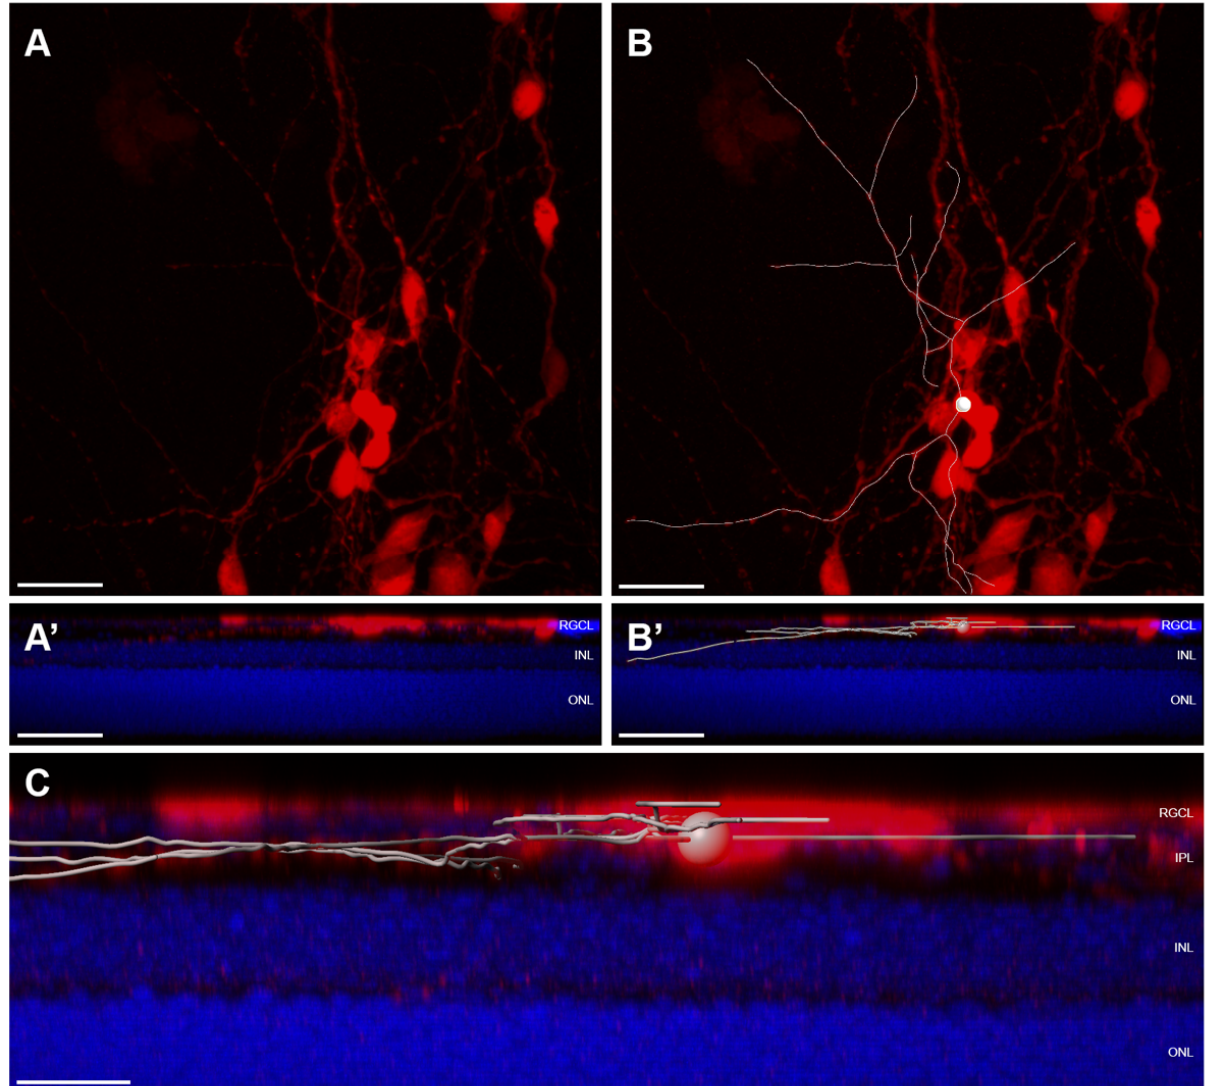
Figure 5. Three-dimensional reconstruction of confocal microscopy showing in vivo transplanted hESC-RGCs (red) in pronase-treated wildtype mouse retinas. En face projections of donor RGC soma and neurite growth ( A ) and tracings of integrated neurites from a single cell in white ( B ). Integrated RGC soma is indicated by the sphere ( B , B’ , C ). DAPI (blue) demarks retinal layers in orthogonal projections of the confocal z-stacks ( A’ , B’ , C ). Scalebars: 30 μm ( A , A’ , B , B’ ); 10 μm ( C ). RGCL—retinal ganglion cell layer; IPL—inner plexiform layer; INL—inner nuclear layer; ONL—outer nuclear layer.